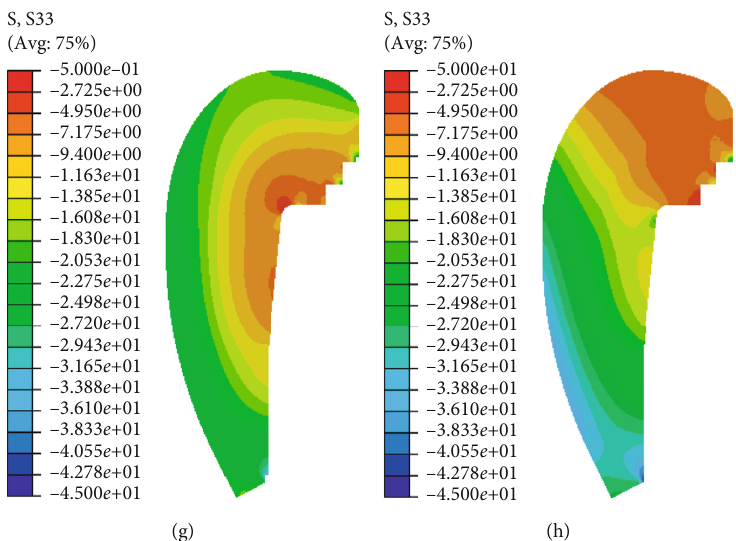
Figure 8: 42s stress of C/C throat insert in motor operation: (a) coupled algorithm for Mises stress, (b) engineering algorithm for Mises stress, (c) coupled algorithm for radial stress, (d) engineering algorithm for radial stress, (e) coupled algorithm for axial stress, (f) engineering algorithm for axial stress, (g) coupled algorithm for circumferential stress, and (h) engineering algorithm for circumferential